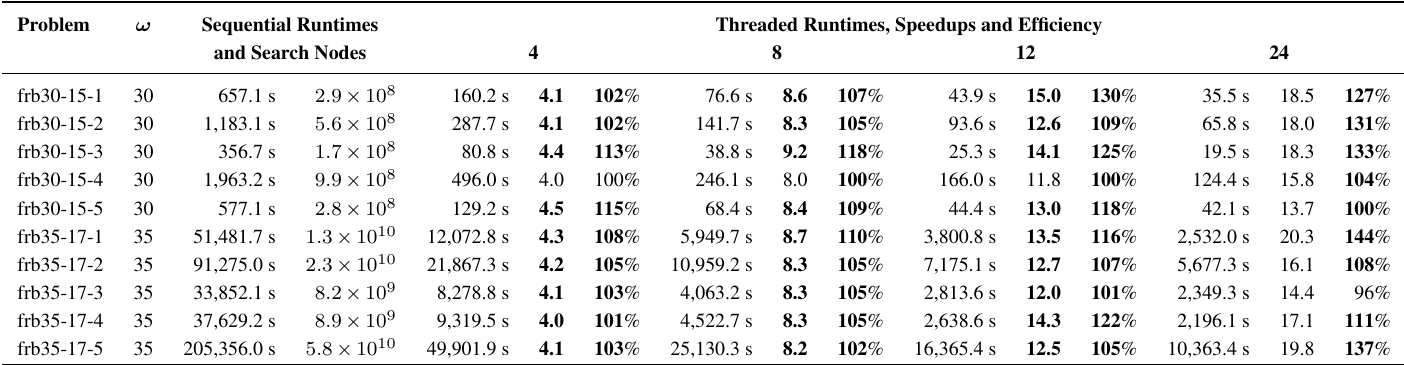
Table 3. Experimental results for BHOSLIB instances. Shown are the size of a maximum clique, then sequential runtimes and the number of search nodes (calls to expand ). Next is parallel runtimes, speedups and efficiency using 4 to 24 threads on a 12-core hyper-threaded system. Superlinear speedups and efficiencies greater than 100% are shown in